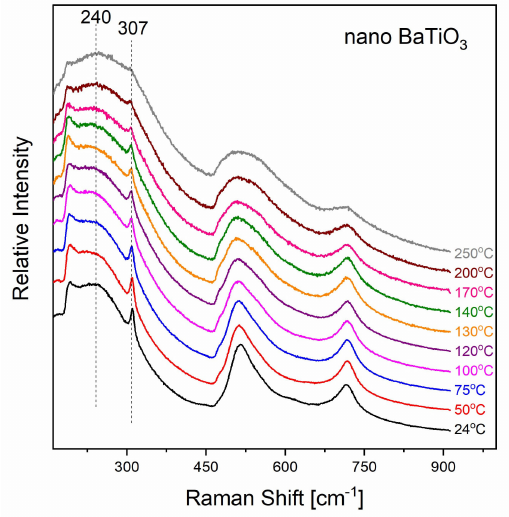
Figure 8. Raman spectra of nano-BT particles in the temperature range from 24 ◦ C to 250 ◦